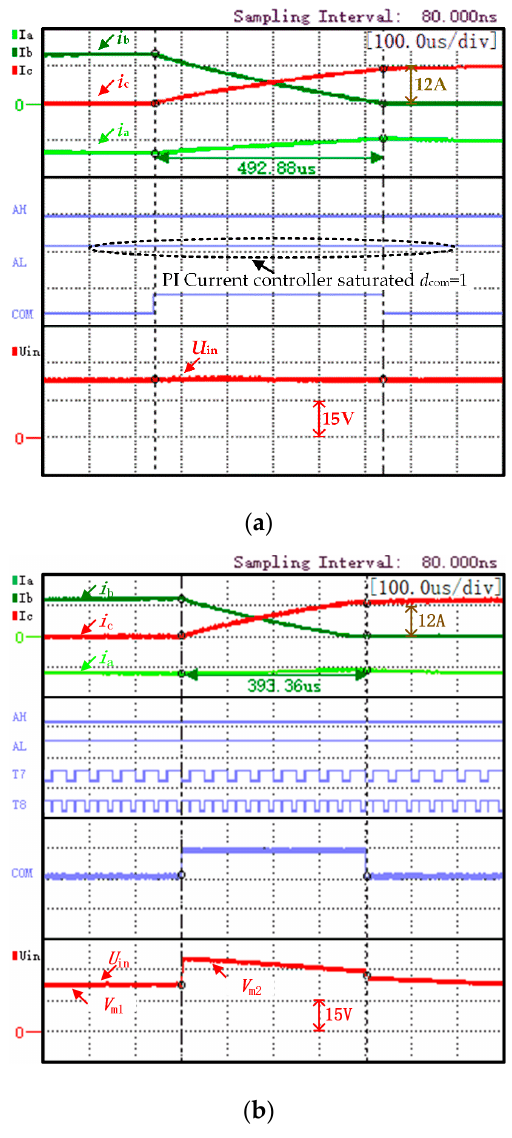
Figure 11. The enlarged views of the experimental results with rated condition: ( a ) traditional strategy; and ( b ) proposed strategy.